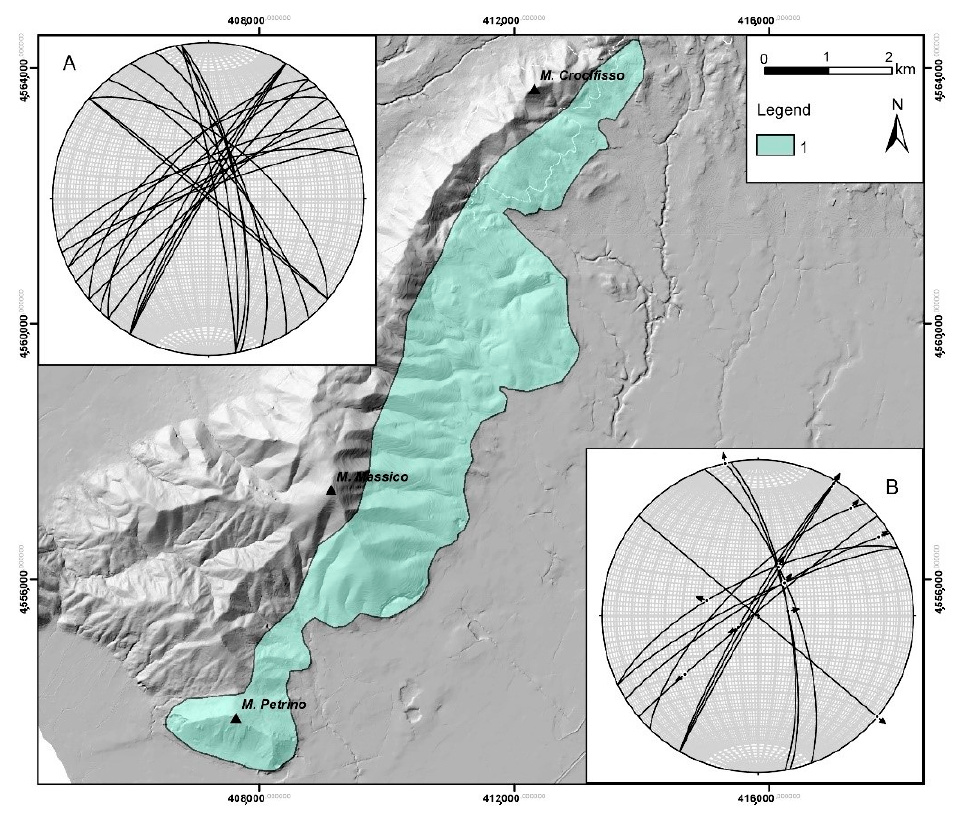
Figure 6. Measurement stations (box 1 in the legend) and related stereoplots of brittle structures from the southern slope of Mt. Massico. ( A ): stereoplot of faults; ( B ): stereoplot of faults with kinematics.